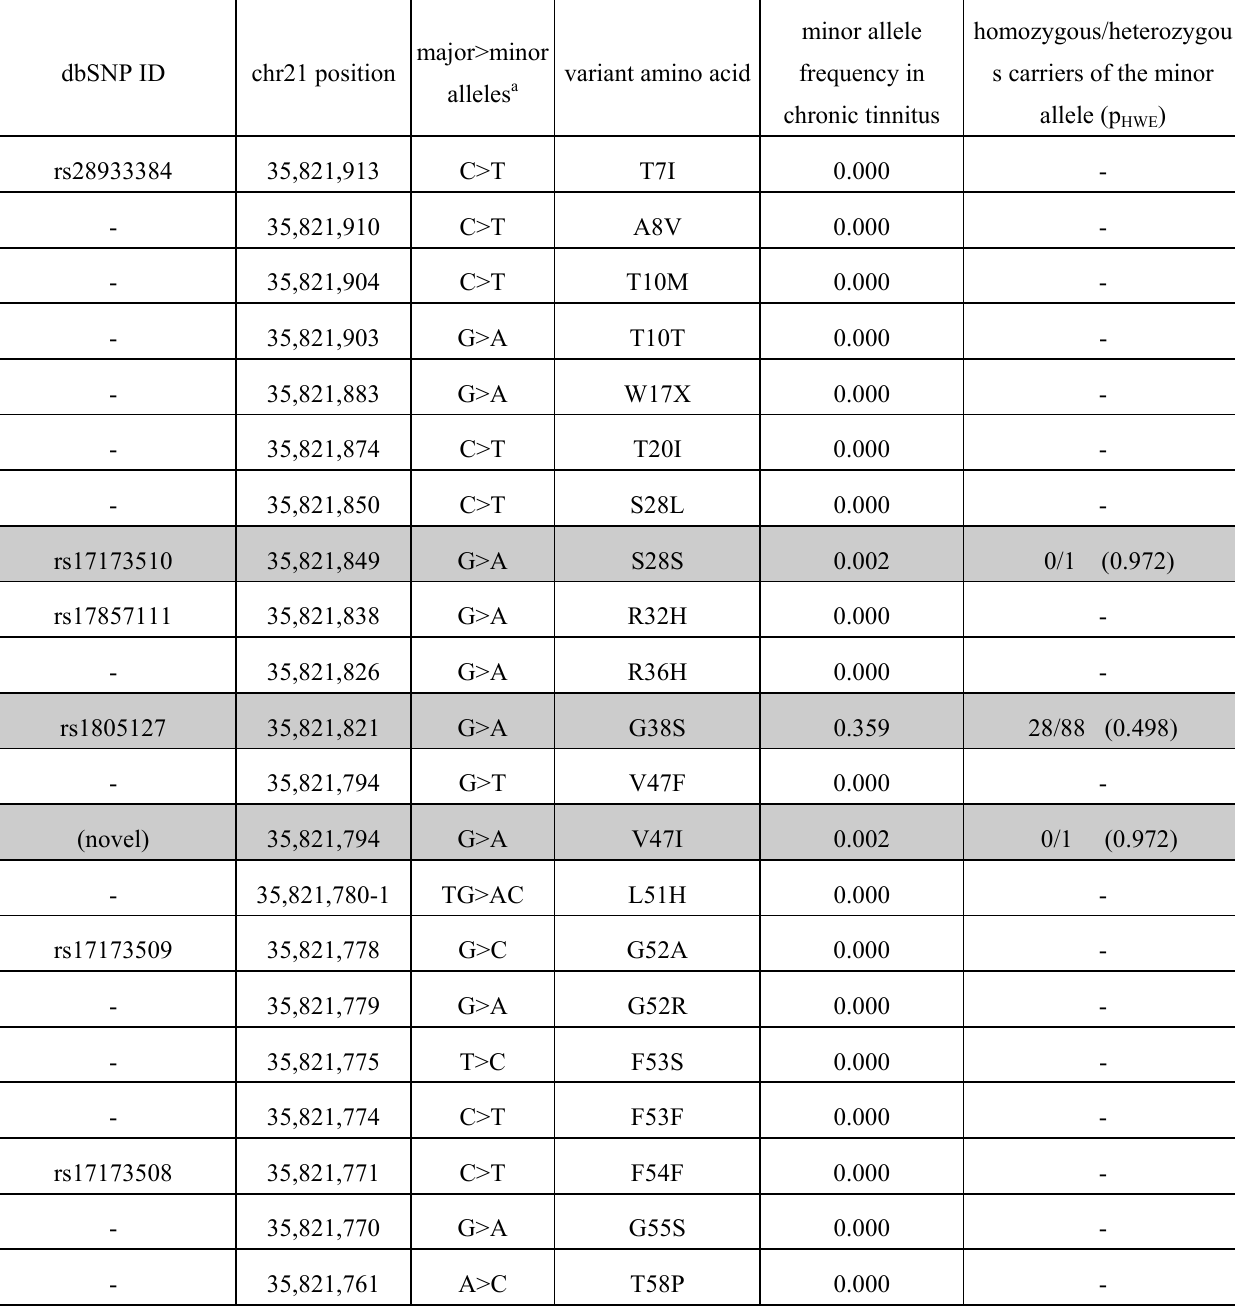
Table 1. Observed allele frequencies for the KCNE1 sequence screened in subjects with chronic tinnitus (N=201). Seven non-monomorphic variants are